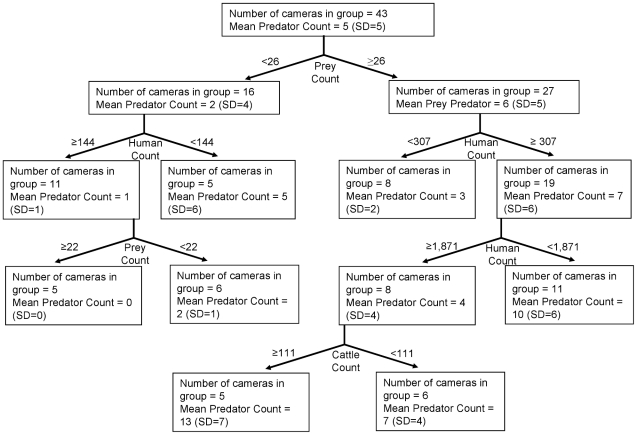
Regression tree analysis of large mammalian predator counts at camera sites in southwest Alberta, Canada during the summer of 2008.For each partition of the tree (indicated by arrows), the explanatory variable is indicated with the value that best determines the partition (i.e., the cut-off point that maximizes homogeneity within a group). Indicated at each node are the number of cameras in the group and the mean number of predator photographs per 100 days (with standard deviation in parentheses).